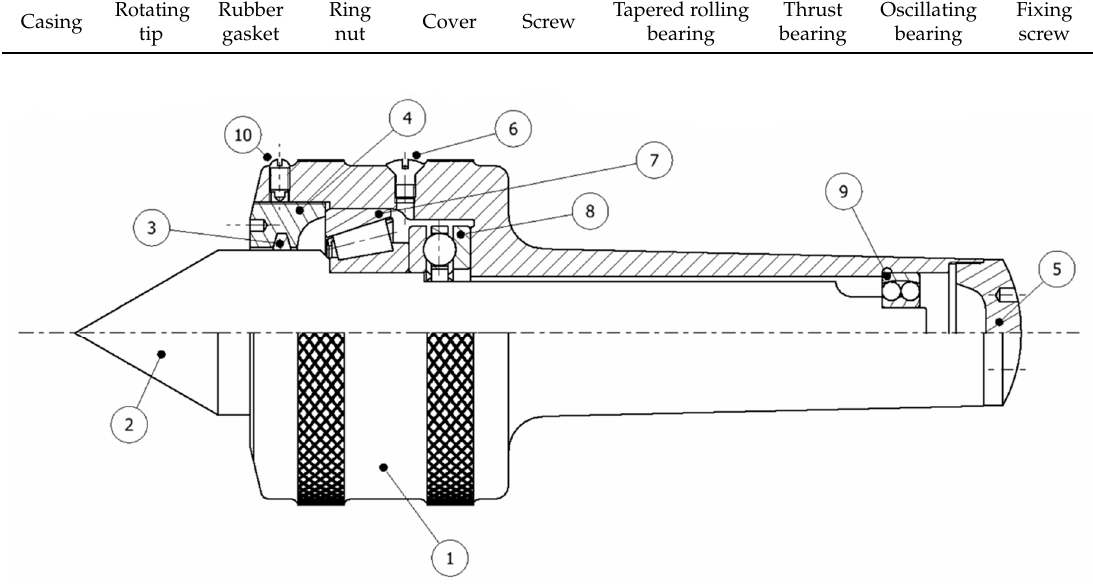
Figure 3. Design of the tailstock realized on Inventor; it is not intended as a complete project